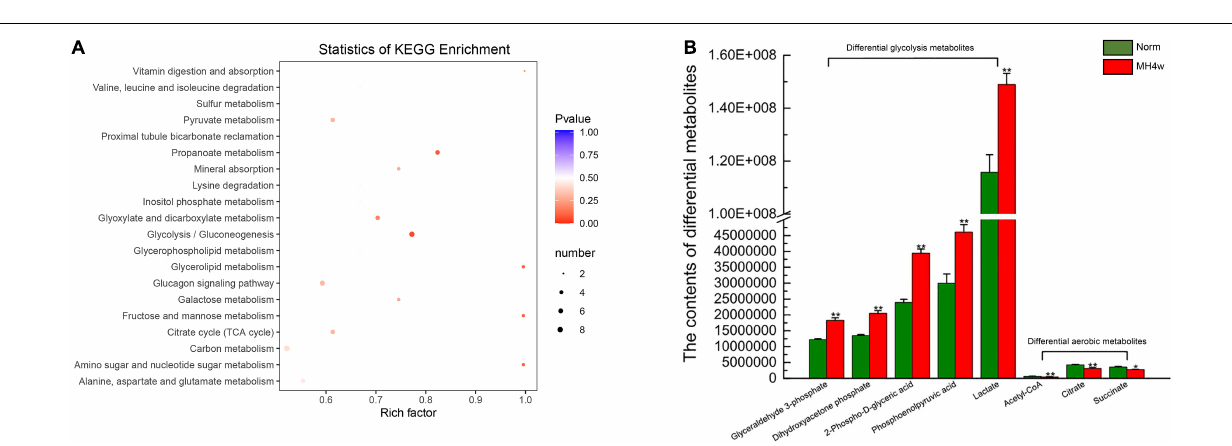
FIGURE 6 | Liver differential metabolites between the two groups (Norm vs. MH4w). (A) Differential metabolite KEGG enrichment; the bigger the circle, the greater is the number of differential metabolites enriched in the pathway, the redder the circle, the more significant the enrichment. (B) Differential metabolites in glycolysis and aerobic metabolism. All data are presented as mean ± SD. Statistical symbols: * P < 0.05 and ** P <